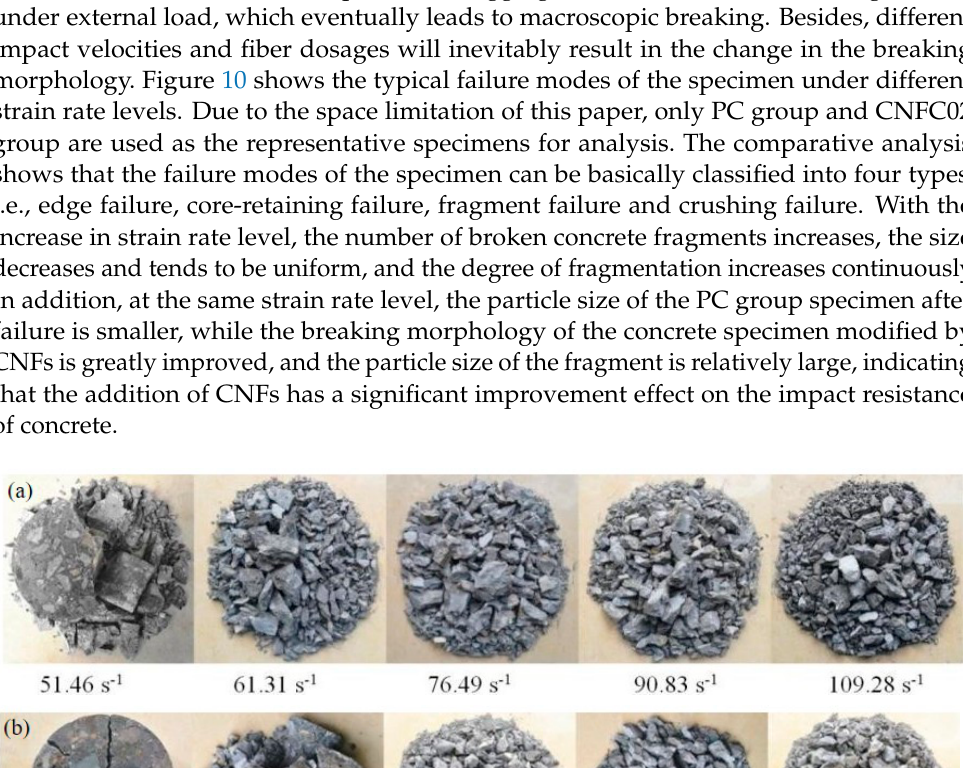
(6) Figure 11. Relationship between d ave and strain rate.